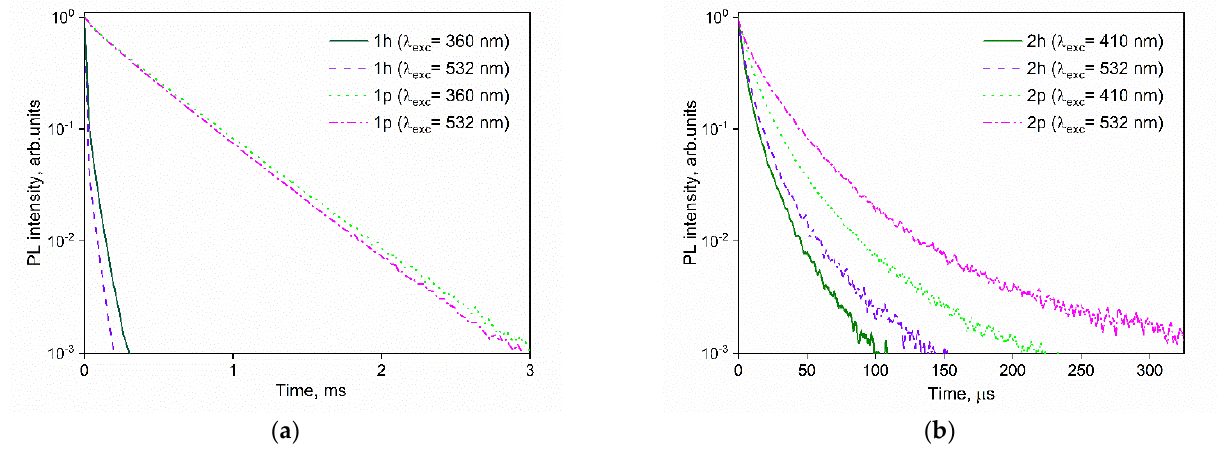
Figure 6. Photoluminescence decays for complexes 1 ( a ) and 2 ( b ) in solid state in the visible spectral range at room temperature excited directly through the ion (at 532 nm) and through the ligand environment (360 nm for 1h and 1p , 410 nm for 2h and 2p ).